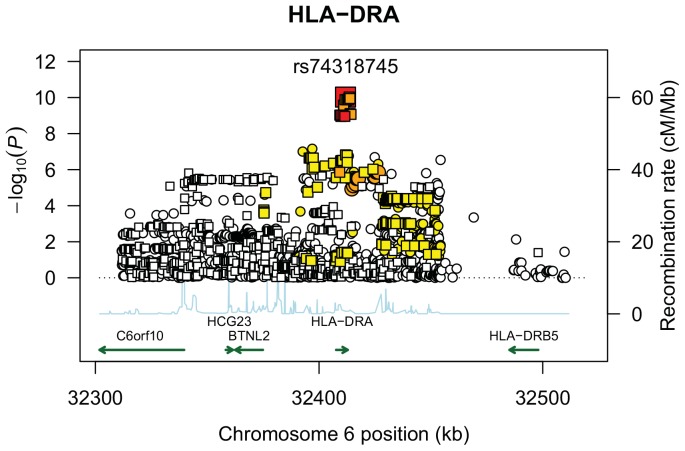
Plot of association test results across chromosome 6p12.1–24.3.The –log10 (P-values) plotted are from SNP association tests adjusted for global percent African ancestry and sex. Association p-values plotted with squares indicate genotyped SNPs; circles indicate imputed SNPs. Shading indicates linkage disequilibrium (LD) r2 values between SNP rs74318745 and the remaining SNPs in the region (strong LD: r2≥0.8 (red); moderate LD: r2≥0.5 (orange); weak LD: 0.8>r2>0.5 (yellow); not in LD: r2<0.2 (white)) were estimated in a sample of 250 unrelated African American controls from the current study. Recombination rates are displayed in blue and are based on the average across the phase II International HapMap reference populations.